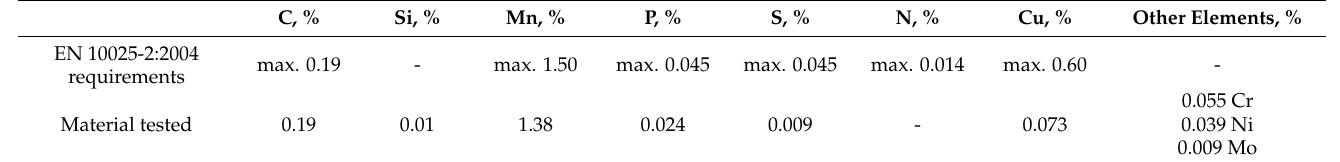
Table 3. Chemical composition of the steel tested (wt %).